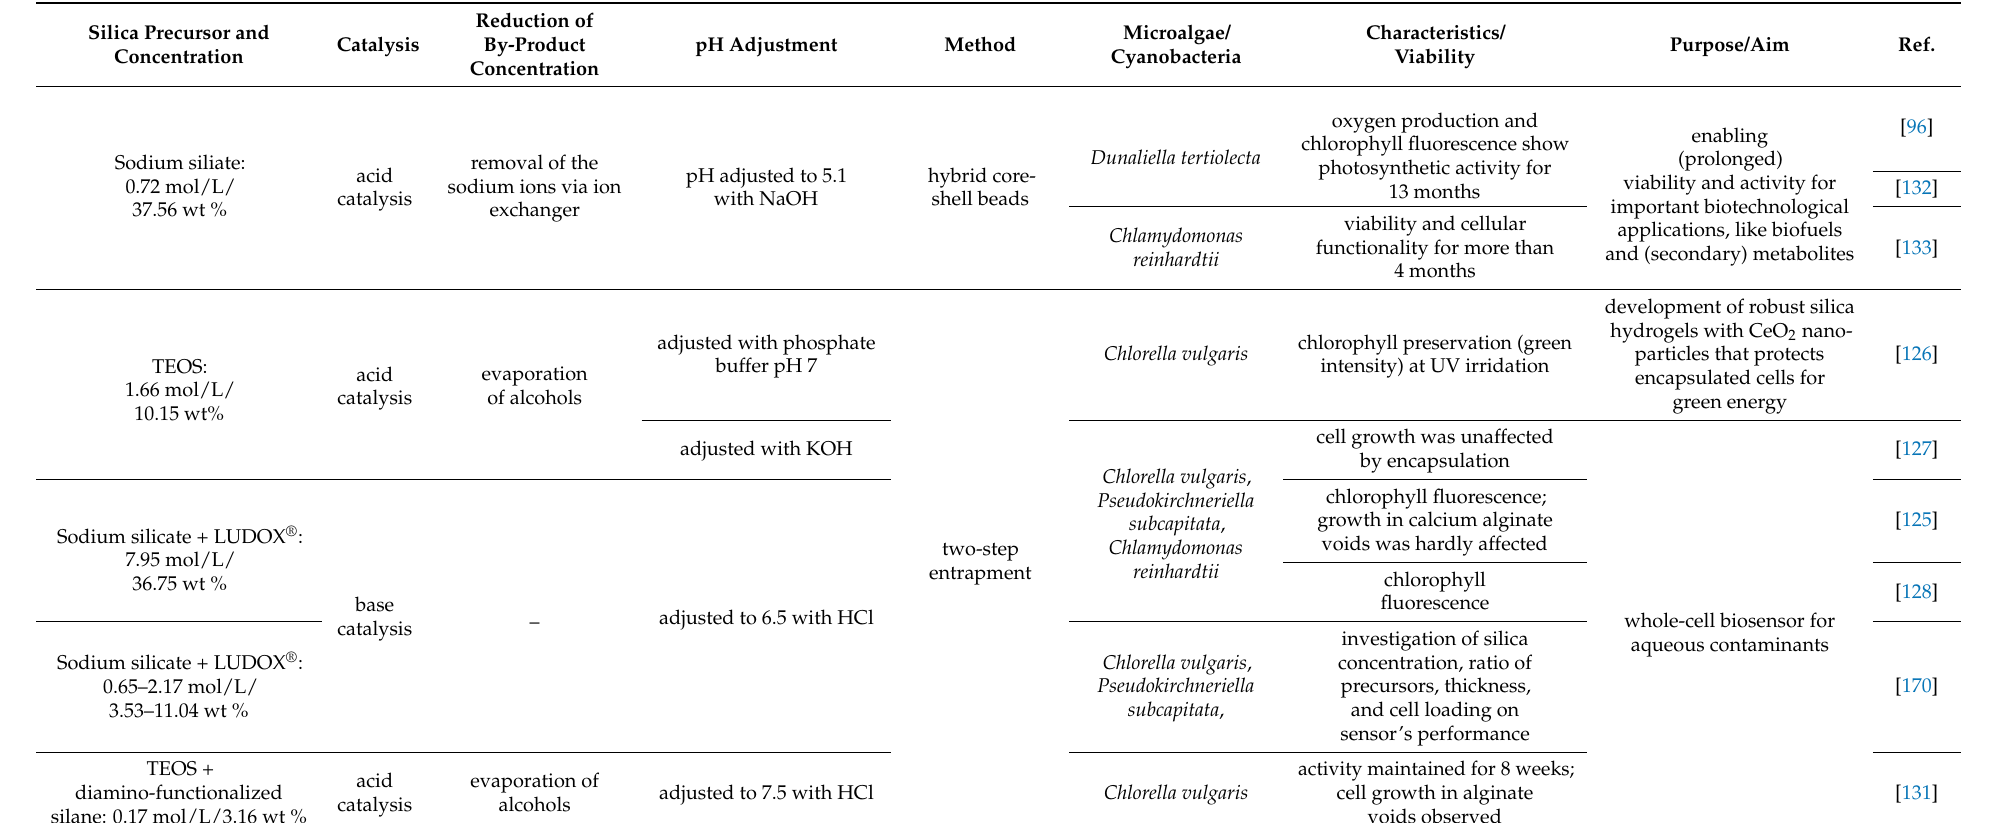
Table 5. Overview of core-shell and two-step entrapment of microalgae. TEOS: tetraethyl